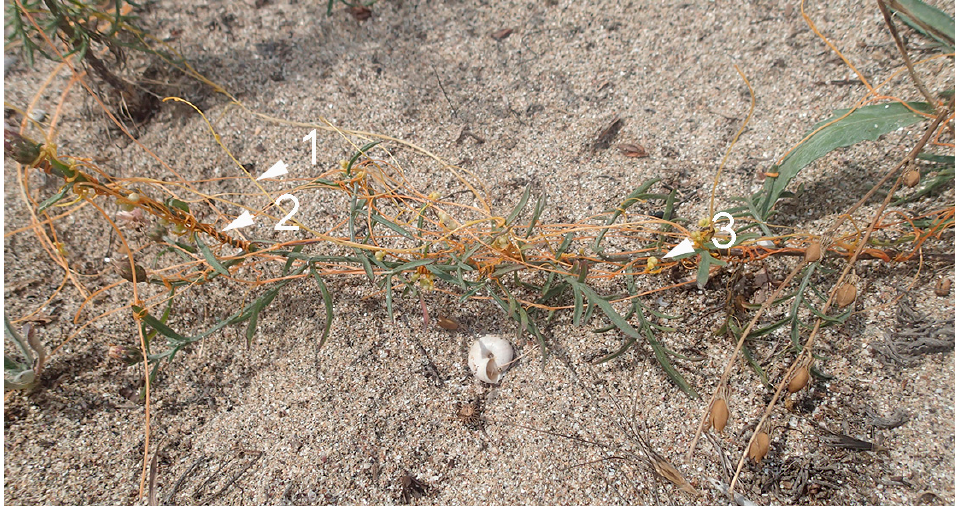
Figure 3. Cuscuta campestris , parasitizing Centaurea arenaria on a sand dune. Bulgarian Black Sea coast, 42°13 ′ 46 ″ N; 27°46 ′ 32 ″ E, July, 2018. White arrows show (1) the parasite stems, (2) site of infection and (3) inflorescence.